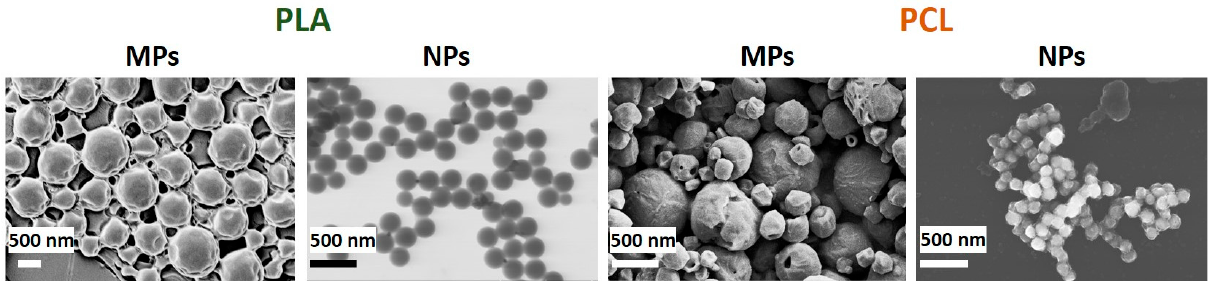
Figure 2. SEM and STEM (for PLA NPs) images of particles prepared via emulsion evaporation and nanoprecipitation techniques. PLA = poly(L-lactic acid), PCL = poly( ε -caprolactone), MPs = microparticles, NPs = and nanoparticles.